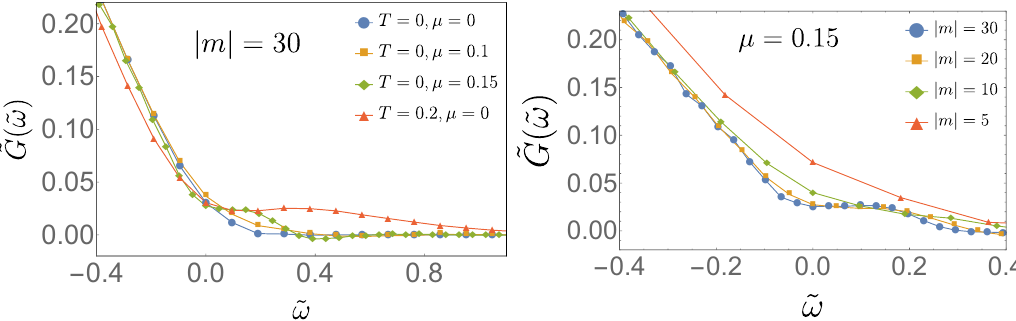
Figure 9: (color online) The influence of non-zero chemical potential and the non- zero temperate of atoms on the power spectrum of Wightman response function. Left panel: The distance to the horizon is fixed | m | = 30 which corresponds to the Un- ≈ 0.015 (see Fig.1). As expected, µ = 0.1 and µ = 0.15 data ruh temperature T U deviate from T = 0 curve only for small positive frequencies. Indeed, the µ = 0.1 curve is very close to T = 0 result. The µ = 0.15 curve exhibits more thermal be- havior, still it less deviates form the perfect case then T = 0.2 curve. Right panel: The power spectrum of Wightman response function for a fixed nonzero chemical potential µ = 0.15. Although the chemical potential is about an order of magnitude larger then the Unruh temperature, we can still distinguish the characteristic thermal properties of power spectra (see